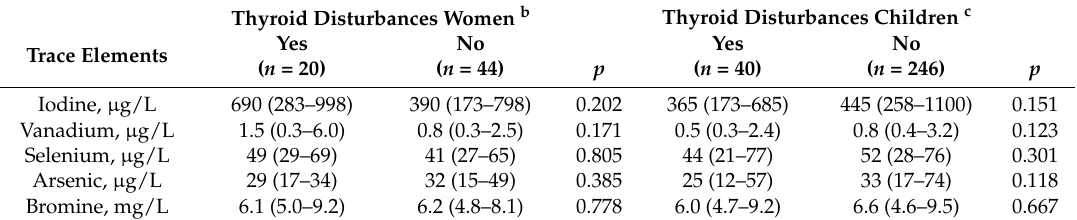
Table 7. Concentration of selected trace elements in urine among women and children with thyroid disturbances a